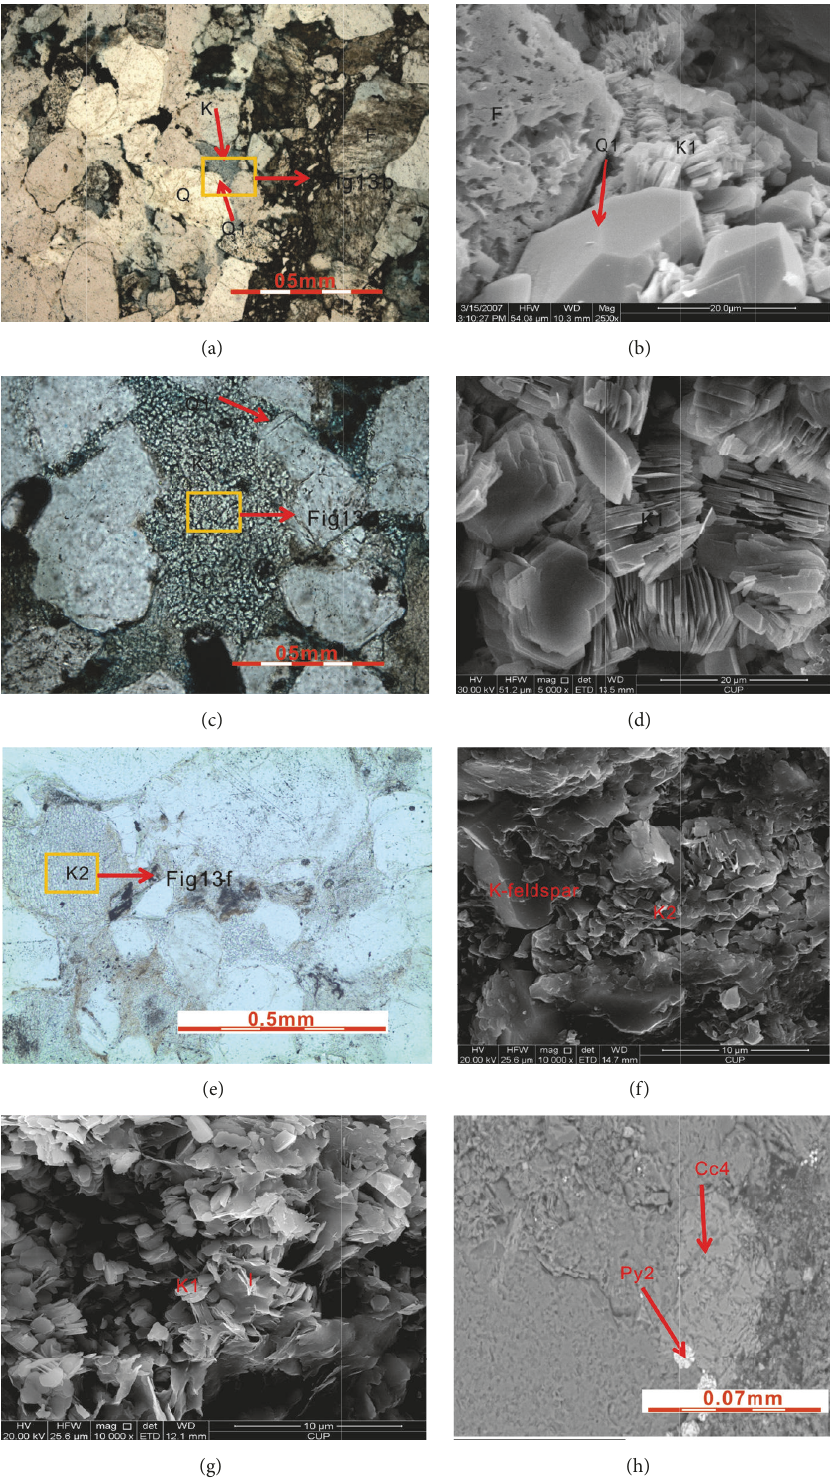
Figure 13: Morphological features of diagenetic products in Es of Dongying Sag . ((a) Well He 142, 3064.83 m, wormlike authigenic kaolinites (K1) intergrew with quartz overgrowths; (b) Well He 142, 3064.83 m, local amplification of (a), K1 intergrew with quartz overgrowths; (c) Well Xin 154, 2938.56 m, K1 filled in secondary pores; (d) Well Xin 154, 2938.56 m, local amplification of (c), wormlike authigenic kaolinite (K1); (e) Well N105, 3096.2 m, disordered authigenic kaolinite distributed on the surface of K-feldspars (K2); (f) Well N105, 3096.2 m, local amplification of (e); (g) Well XX161, 3272.5 m, illitization of K1 and K2; (h) Well S106, 3398.70 m, Cc4 and